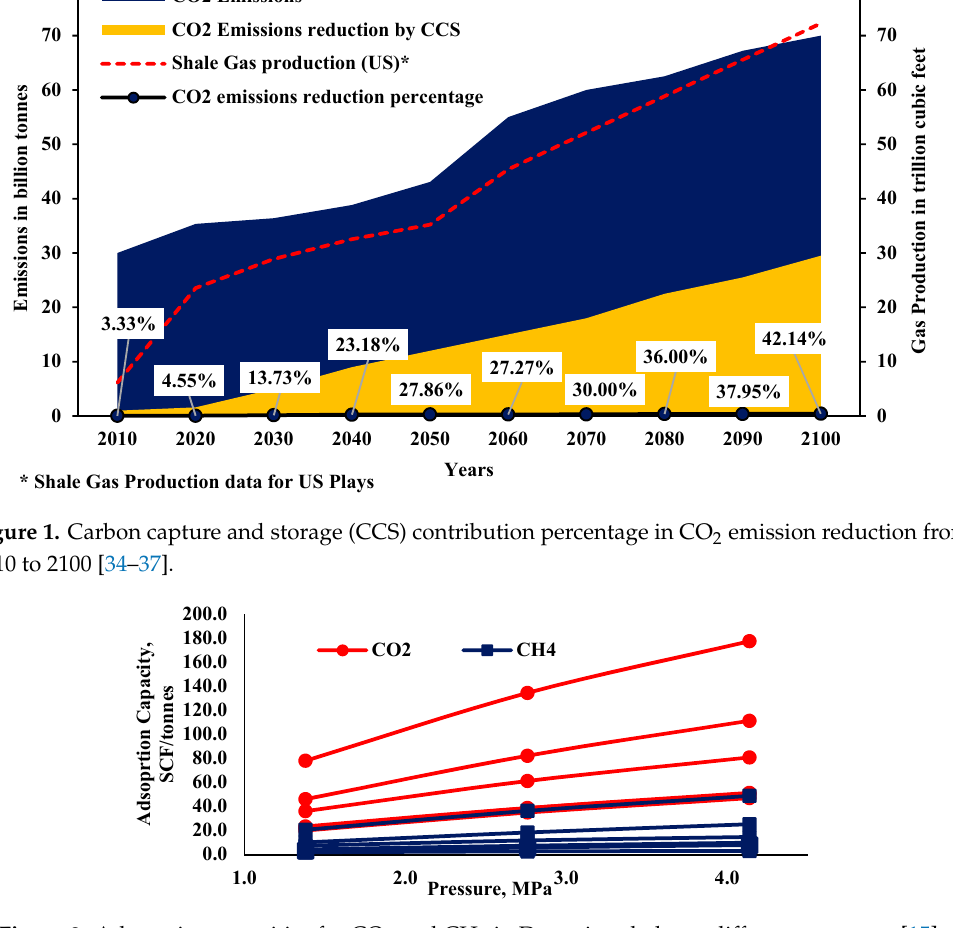
Figure 2. Adsorption capacities for CO 2 and CH 4 in Devonian shales at different pressures [15].